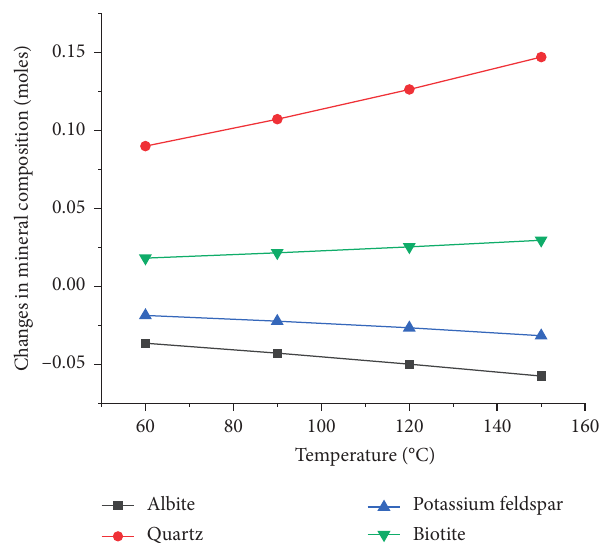
Figure 8: The calculated results for granite compositional changes after water and granite interactions at different